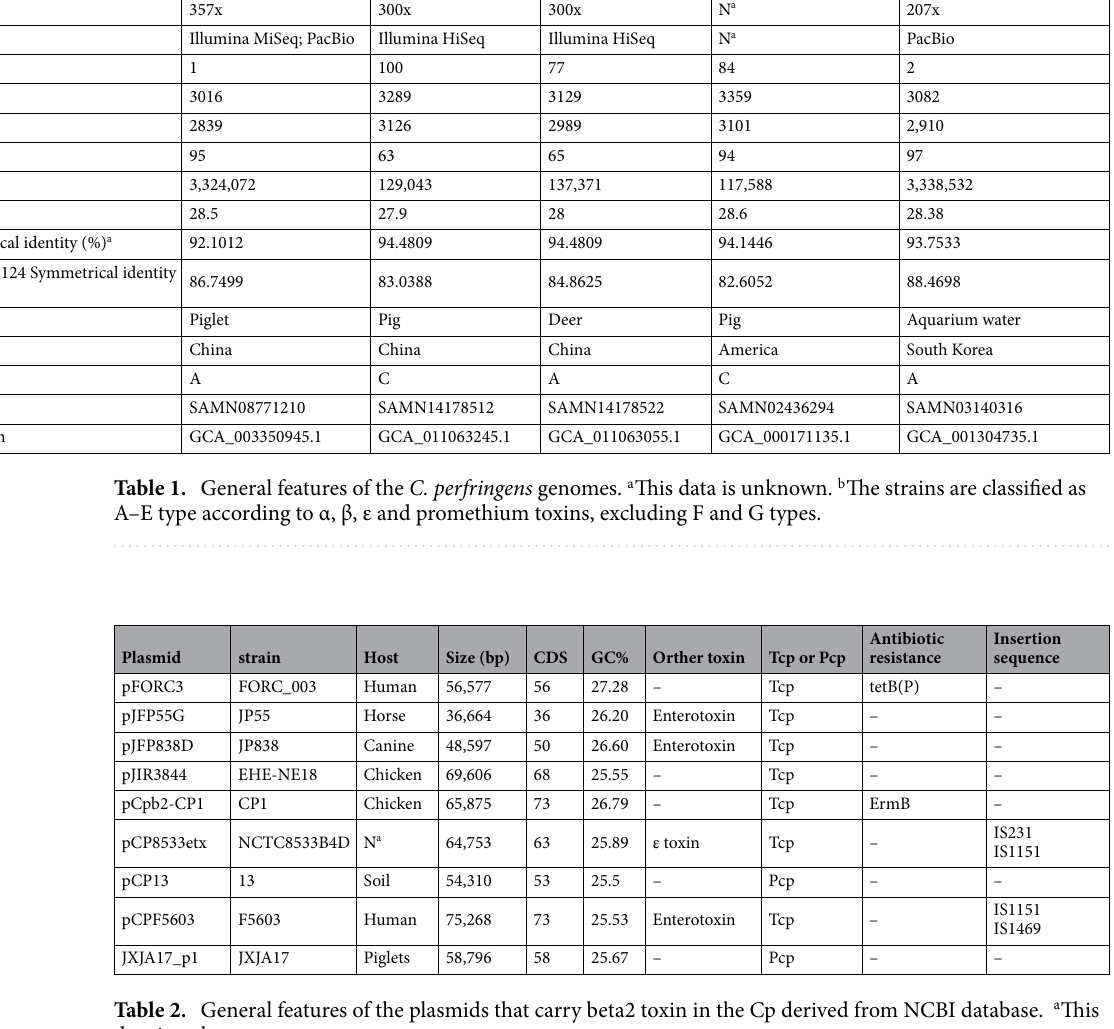
Table 2. General features of the plasmids that carry beta2 toxin in the Cp derived from NCBI database. a This data is